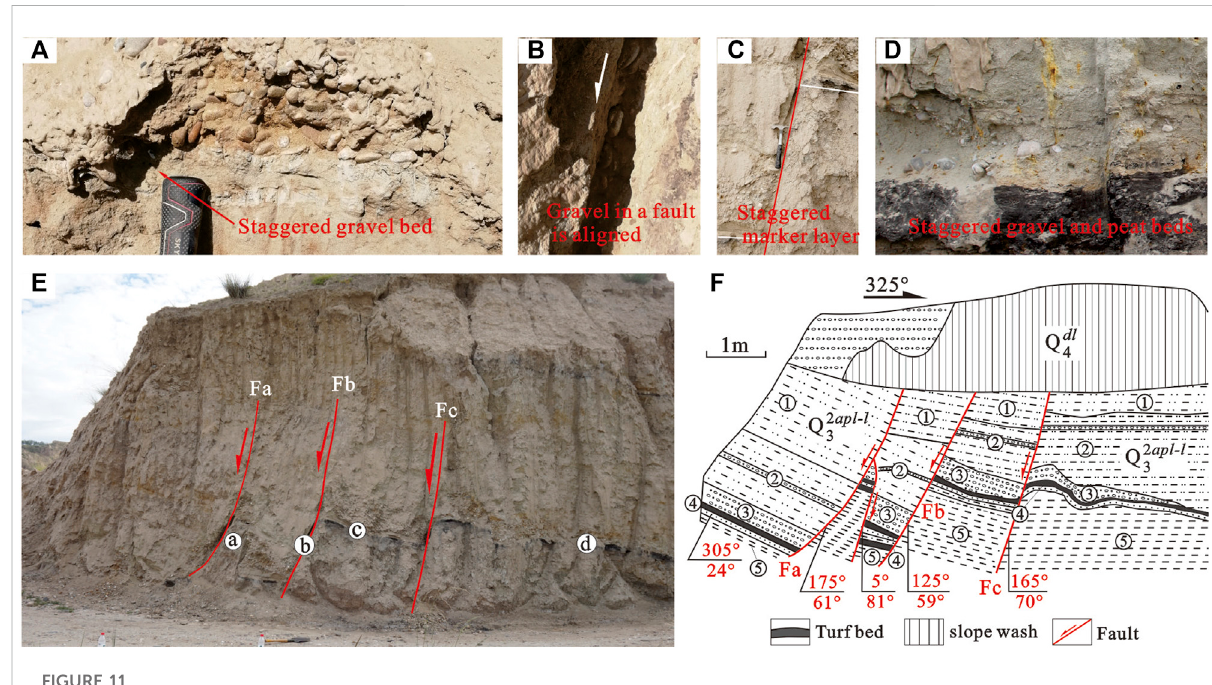
FIGURE 11 Stepped normal fault system in northwestern Kecai village